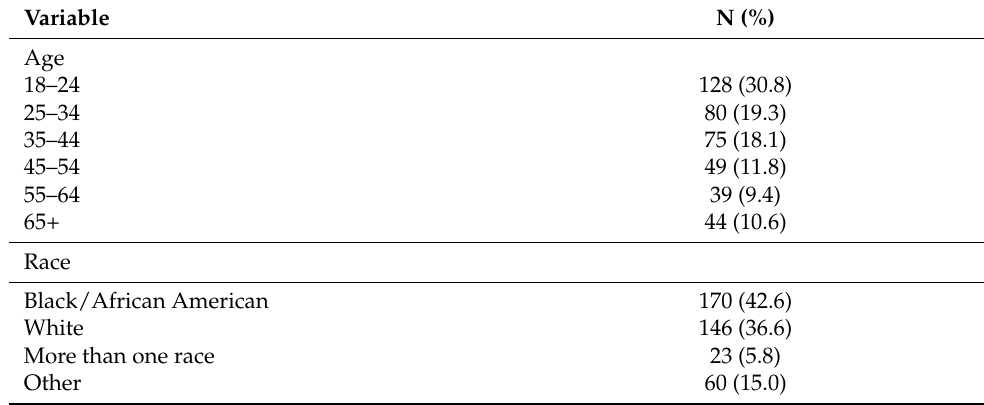
Table 1. Descriptive characteristics of study participants, New York, United